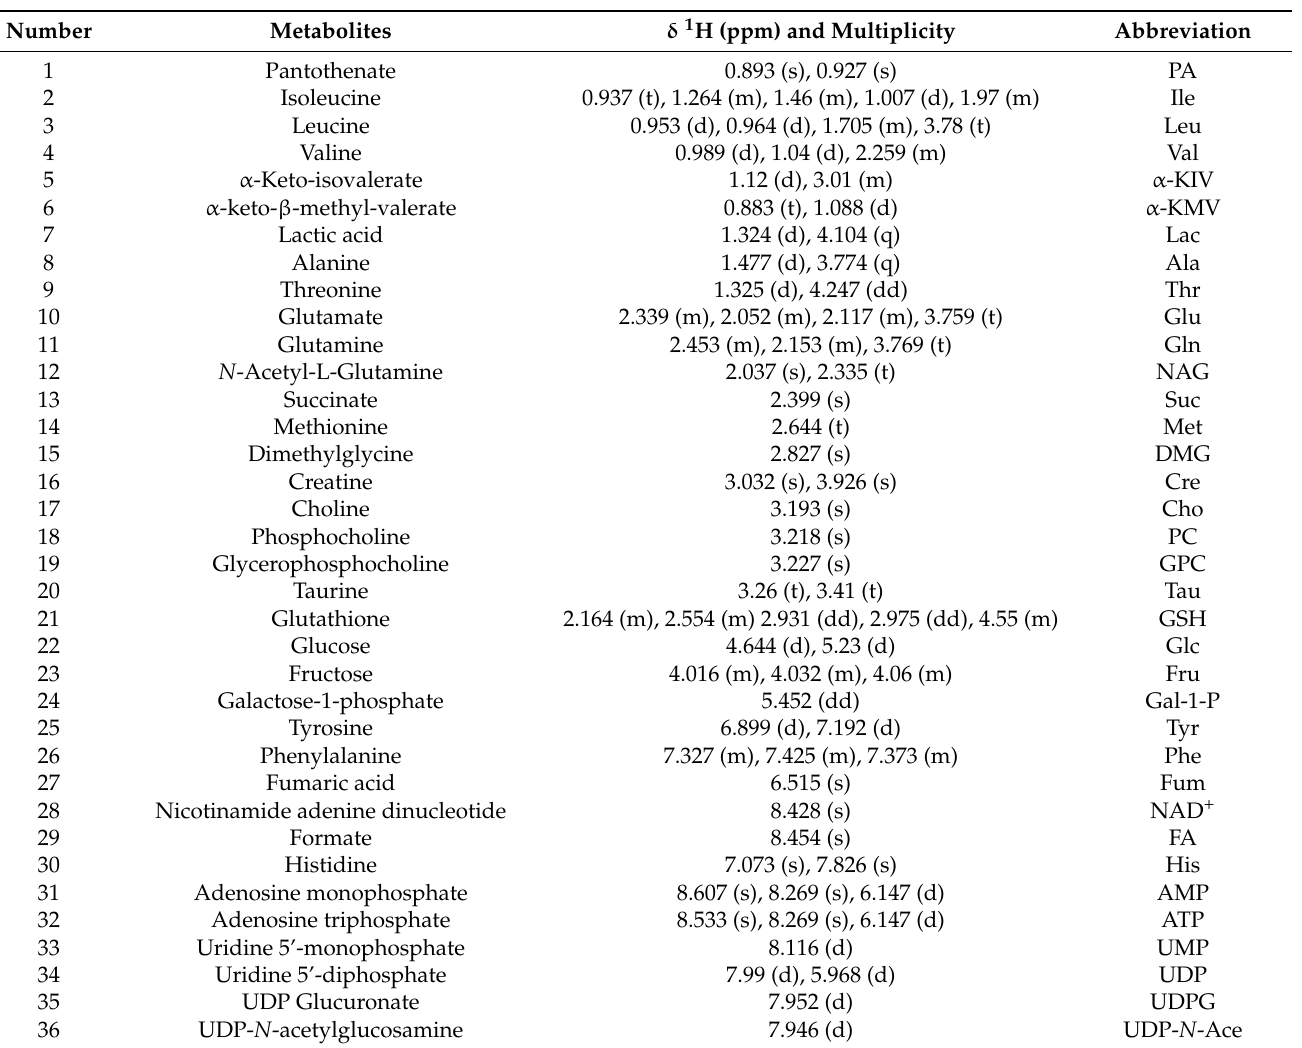
Table 1. 1 H NMR assignment for the metabolites from the cell extracts.